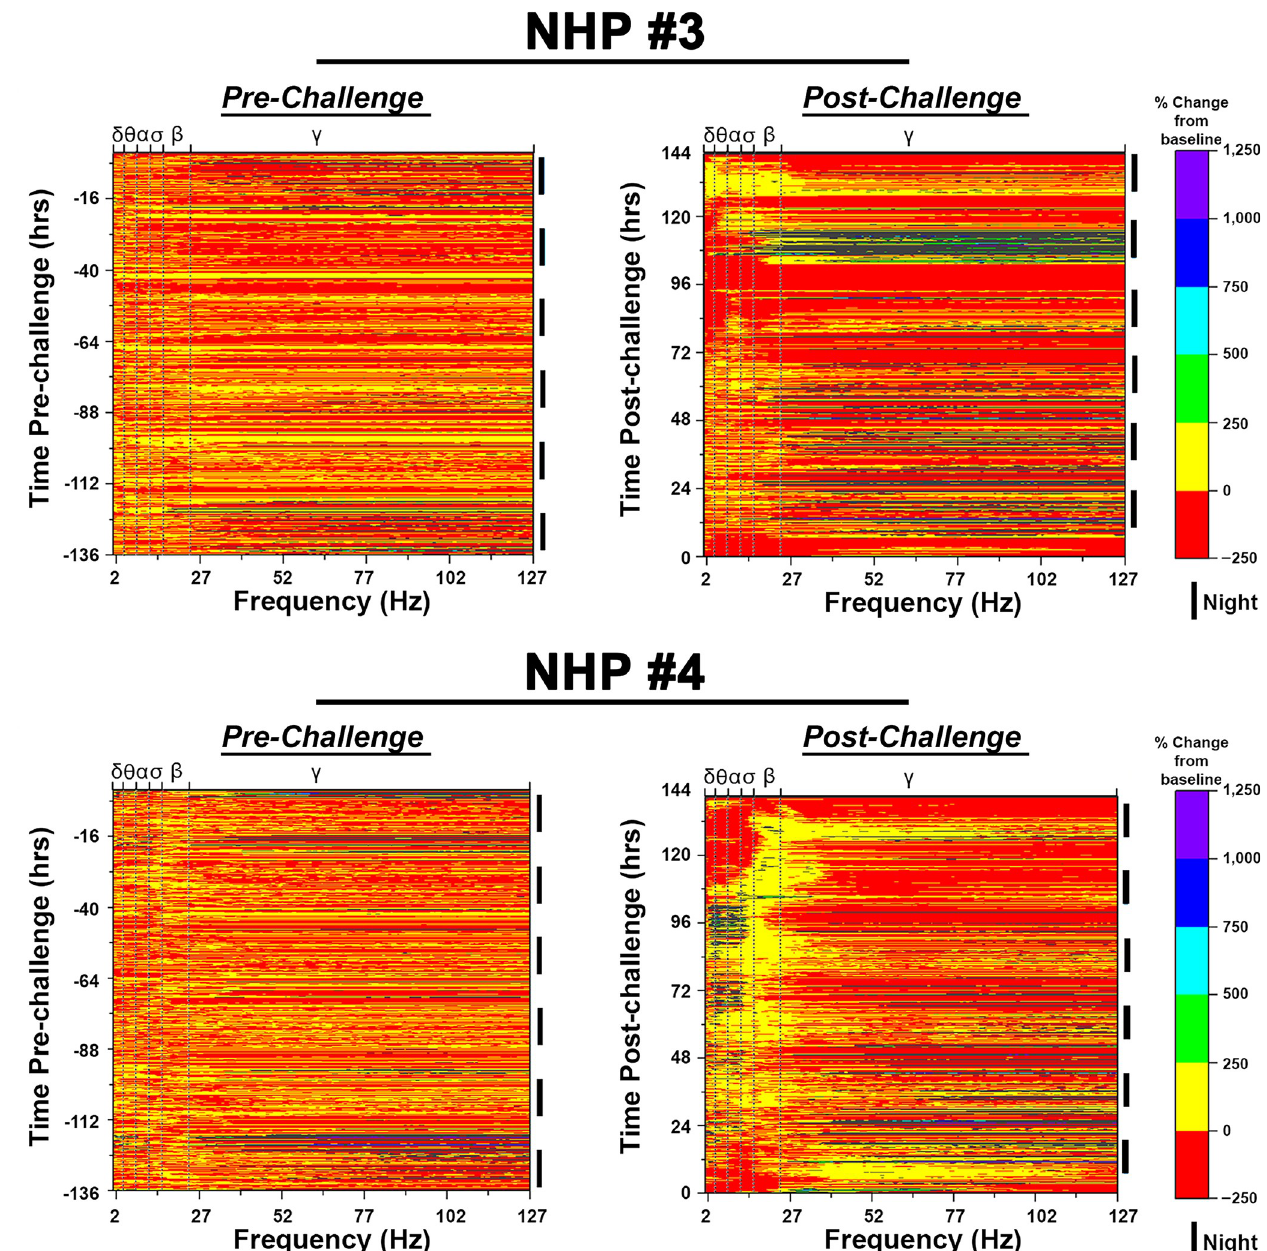
Fig 12. Pre- and post-EEEV challenge quantitative electroencephalography (qEEG) heat maps of NHPs #3 and #4. The top and bottom x-axes display brain waves [(delta ( δ ), theta ( θ ), alpha ( α ), sigma ( σ ), and gamma ( γ )] and frequency in hertz (Hz), respectively. The left and right y-axes display time (hr) and 12-hr day/night time intervals, respectively. 12-hr nighttime is indicated by ( ▐ ) and daytime by a gap. Pre-EEEV challenge baseline (left) and post-EEEV challenge (right) heat maps are